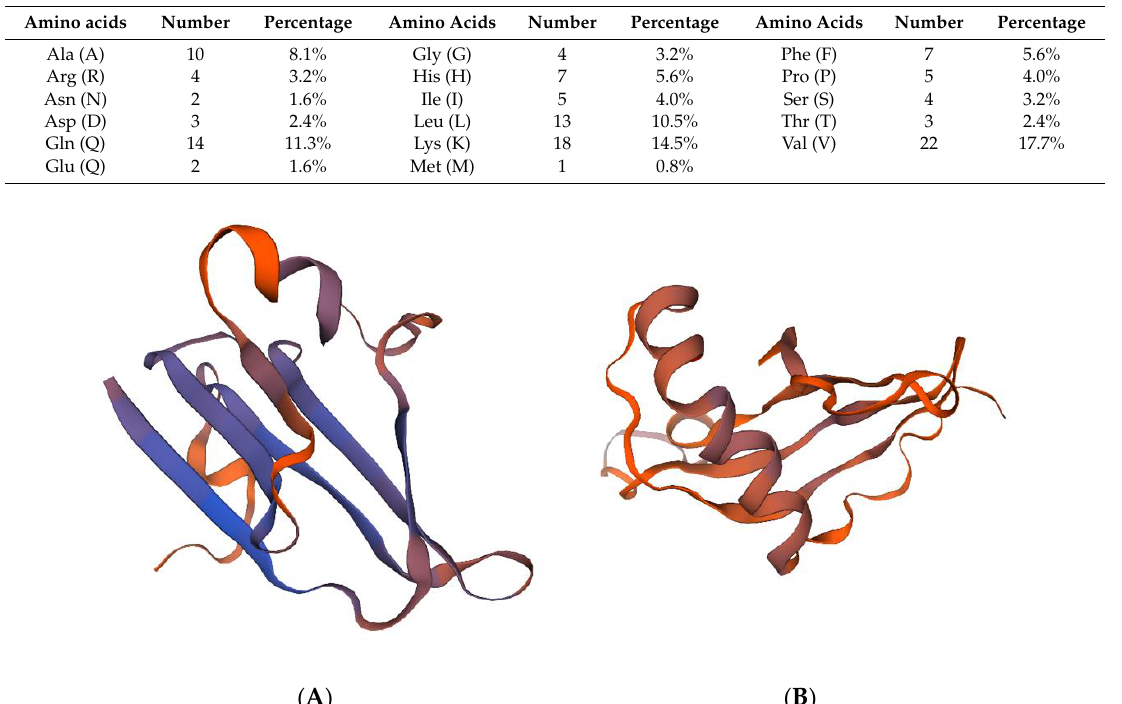
Figure 2. The picture of three-dimensional structure of ( A ) Bx-TLP-2 and ( B ) Bx-CPI.